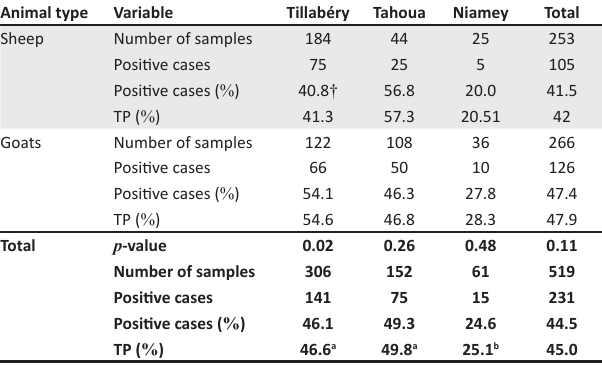
TABLE 3: Prevalence of peste des petits ruminants in sheep and goats according to location. Animal type Variable